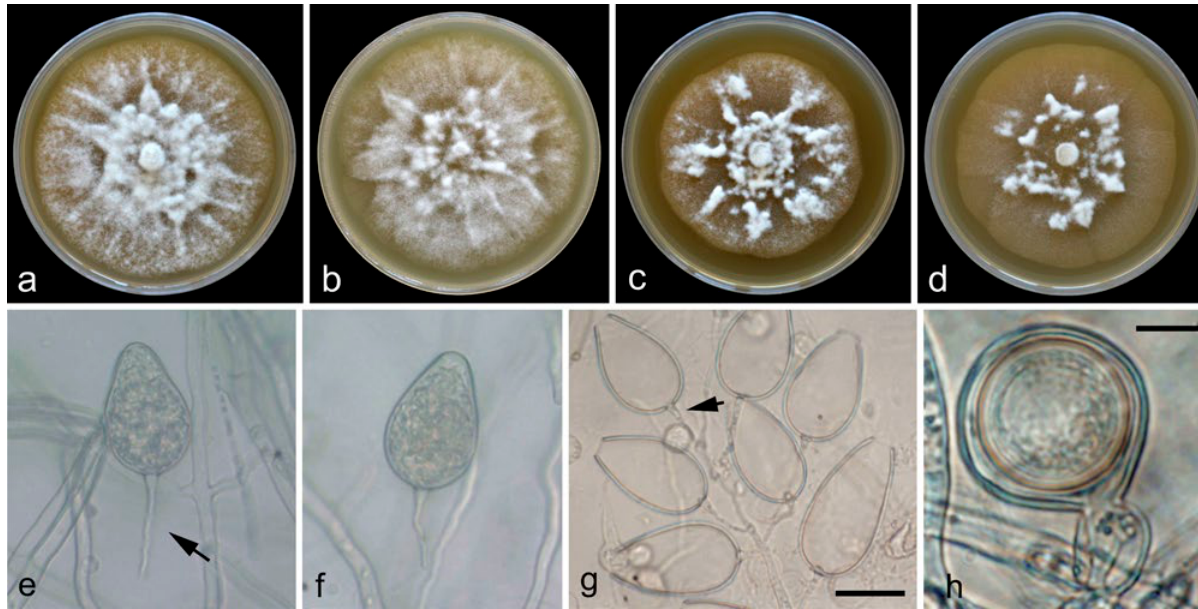
Figure 2. Colony morphologies of Phytophthora ilicis isolates after 7 d on carrot agar: PH046 and PH136 from Sardinia (a-b), P1900 and P1567 from the United Kingdom (c-d). Phytophthora ilicis structures: non-papillate caducous sporangium with long pedicel (arrow) (e), semi-papillate caducous sporangium (f), sympodial sporangiophores with empty sporangia and short pedicel (arrow) (g), oogonium with amphyginous antheridia (h). Bars = 20 μm for sporangia and 10 μm for